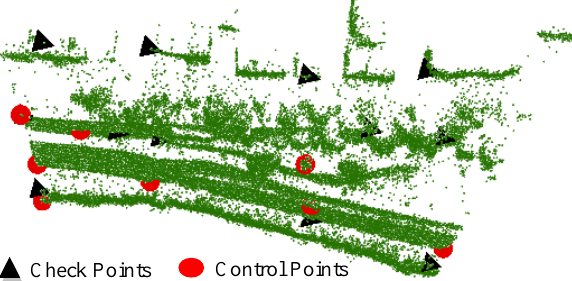
Figure 4. Spatial distribution of control points and check